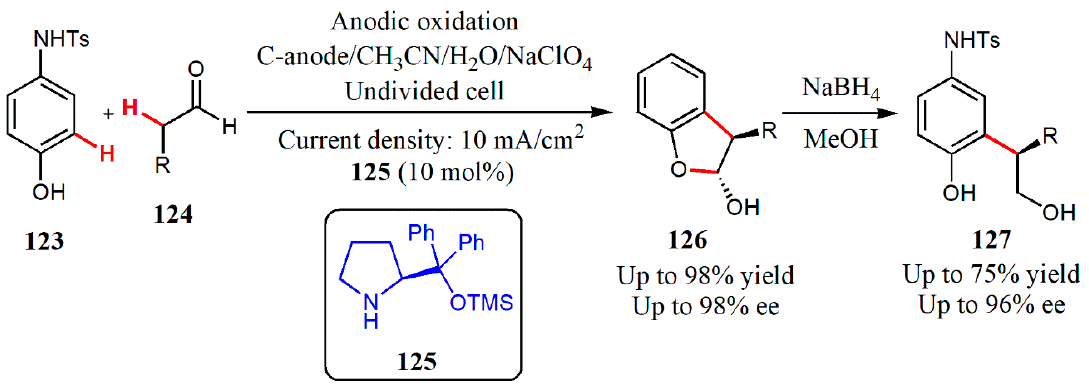
Figure 38. Electro-organocatalysis in the enantioselective α -arylation of aldehydes.